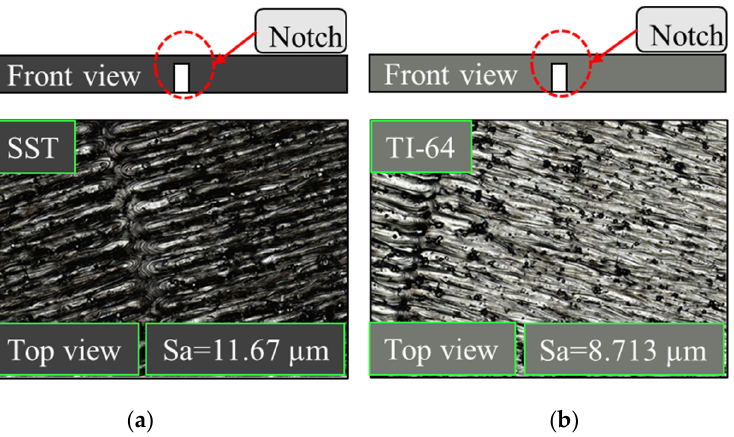
Figure 4. The surface roughness size for both materials where ( a ) stainless-steel (316) sample, ( b ) Titanium sample (TI-64).